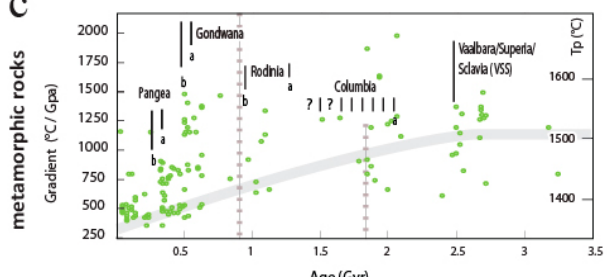
Figure 12. ( a ) Variation in the thickness of juvenile continental crust through time (light red dots), calculated from the relationships in Figure 7b (mafic magma proxy). A polynomial curve ( N = 6) fitting the crustal thickness values (step of 100 Myrs) was reported on the graphs. R 2 corresponds to the coefficient of determination associated with the polynomial curve. The thickest sections of crust are mostly observed in the Proterozoic times (>40–50 km). ( b ) Comparison with crustal thickness estimates using a different proxy (Rb/Sr, [18]). Data distribution of anorthosites forming after Fe-rich magma [41] is given by the histogram (light blue columns). ( c ) Thermal evolution curve (grey) for ambient mantle (Tp) [28]. Green circles superimposed on the graph correspond to the plot of thermal gradients versus age for the three main types of extreme metamorphic belts [42]. They define a trend towards colder gradients in the Phanerozoic. A similar fanning arrays of Phanerozoic magmatic amphiboles and pyroxenes, following the Rodinia supercontinent breaking up and encompassing the Pangea